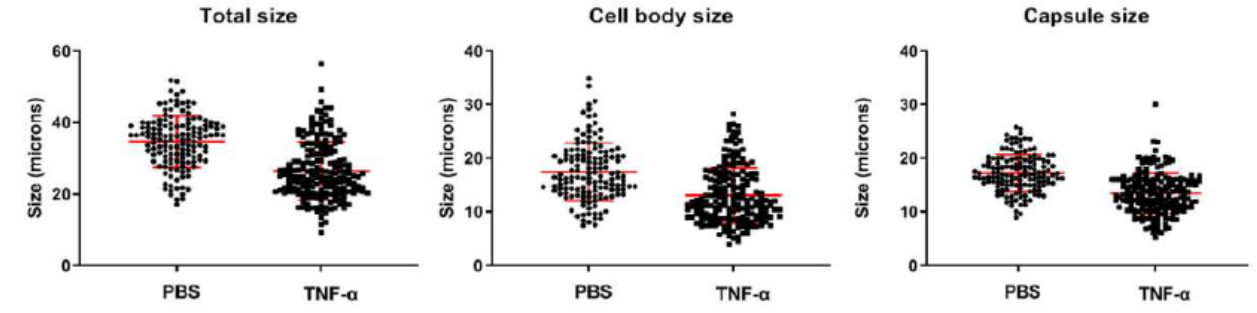
Figure 8. Size of C. neoformans in lungs of mice after administration of TNF- α . ( A ) Distribution of total cell size, ( B ) cell body size, and ( C ) capsule size of C. neoformans H99 cells isolated from lungs of C57BL/6J after 48 h of infection with a dose of 10 6 cells/mouse. Groups of 4 mice were administered TNF- α 200 µg/Kg or PBS (same volume) intraperitoneally 1 h prior to cryptococcal infection. Experiment was repeated twice with similar results.